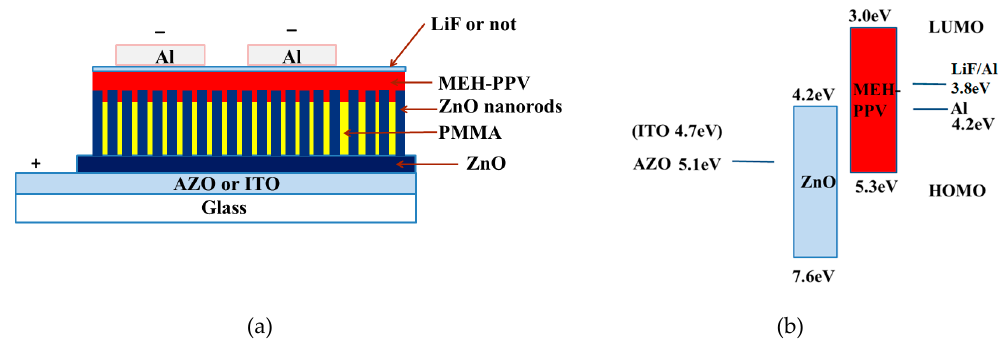
Figure 1. ( a ) schematic diagram and ( b ) energy band diagram of all the devices.